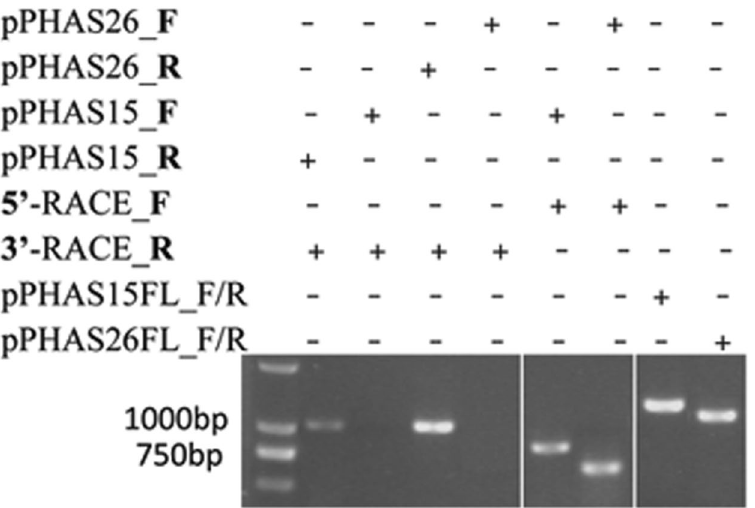
Figure 2. RACE analysis for PHAS15 and PHAS26